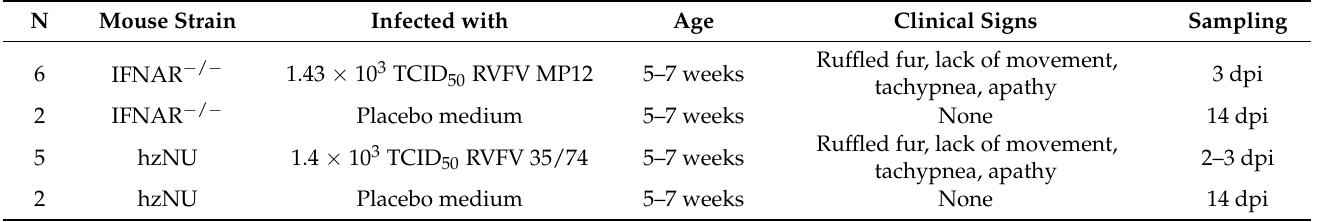
Table 1. Animal overview, applied treatment, age of animals, clinical signs and time point of tissue